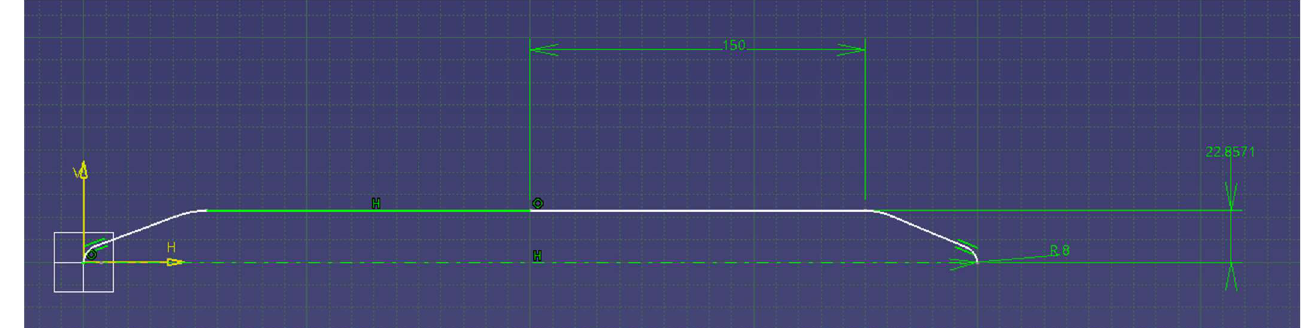
Figure 4. A typical front view of the developed half portioned fuselage.